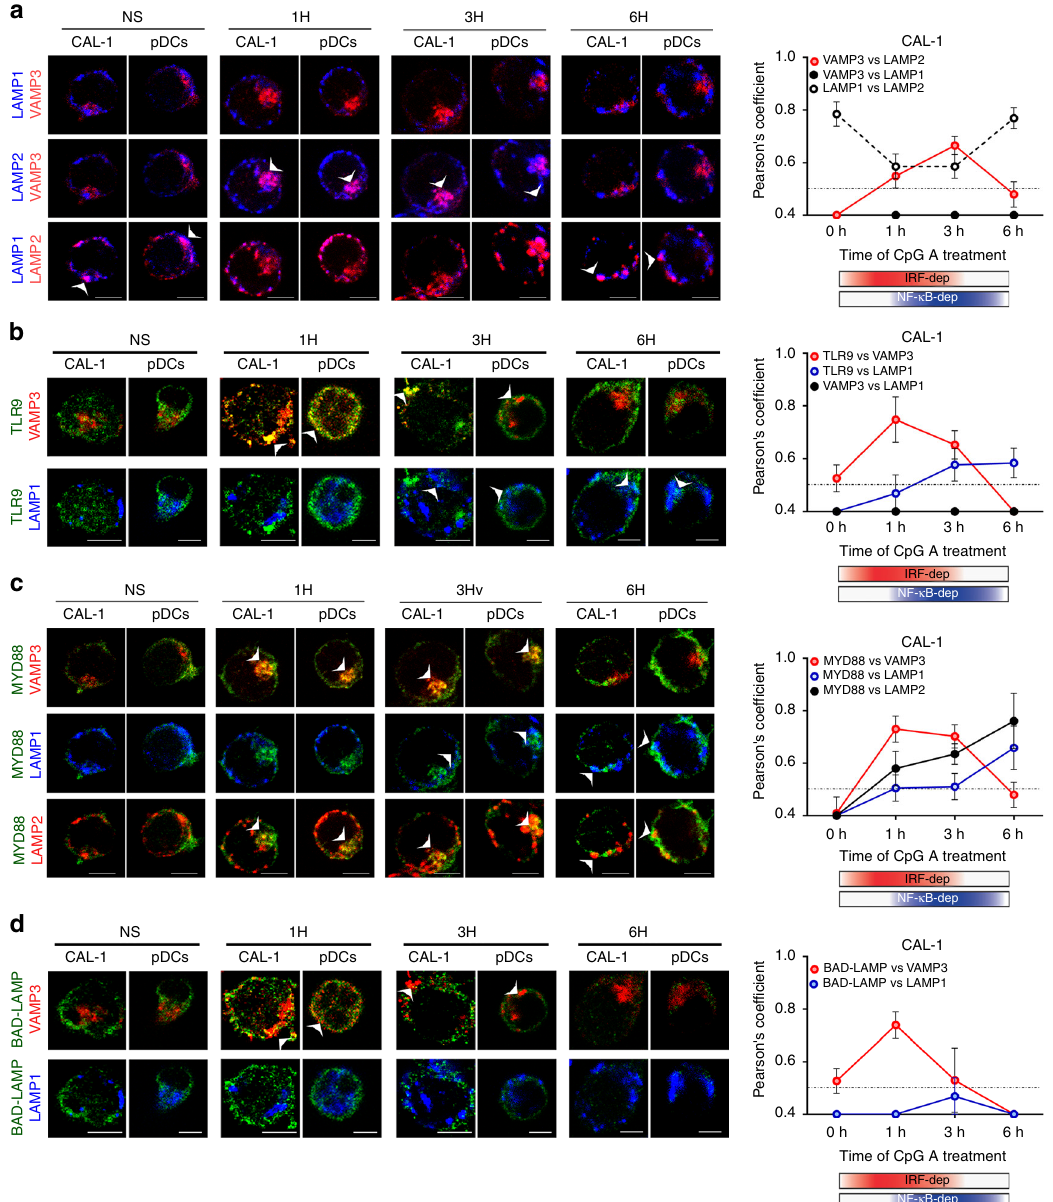
Fig. 4 Upon activation TLR9 and BAD-LAMP are addressed to specialized endosomes. a – d ( left ) Immuno fl uorescence confocal microscopy (ICM) on CAL- 1 or freshly isolated pDCs stimulated with CpG-A for indicated times and stained of ( a ) LAMP1, LAMP2 and VAMP3; ( b ) TLR9, VAMP3 and LAMP1; ( c ) MYD88, LAMP1, LAMP2 and VAMP3; ( d ) BAD-LAMP, VAMP3 and LAMP1. Pictures are representative of at least three independent experiments. Arrows indicate co-localisation areas. Scale bars = 5 μ M. ( right ) a – d Quanti fi cation of the co-localisation between the different proteins across time was performed by Pearson ’ s coef fi cient measurement using ImageJ. Graphics represent Pearson ’ s coef fi cient means of 50 different cells ± s.d. from at least three independent experiments, signi fi cance of pixel correlation is only considered above a PCM of 0.5. The bimodal regulation of TLR9 signalling is represented with a shading red rectangle for its IRF7-dependent phase and blue for its NF- κ B-dependent phase